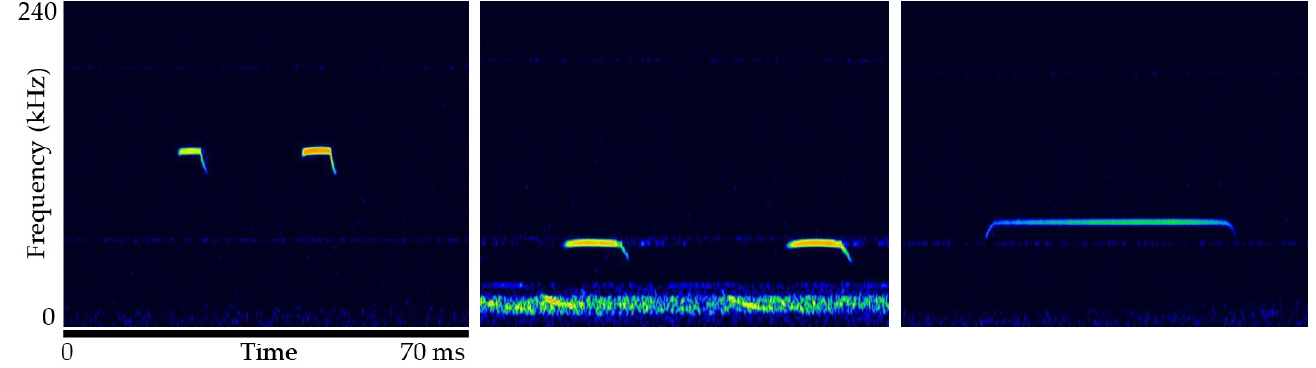
Figure 6. Echolocation calls of CF bat species: A. stoliczkanus ( left ), H. scutinares ( center ) and R. thomasi ( right ).